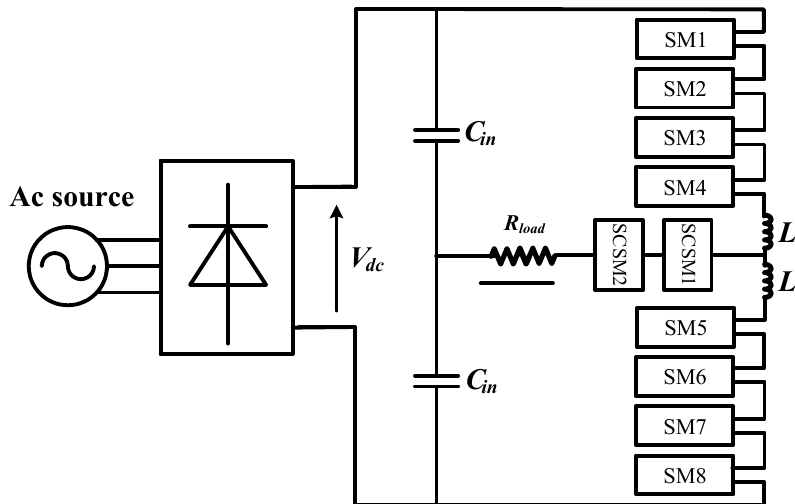
Figure 29. Experimental structure of the modified MMC.